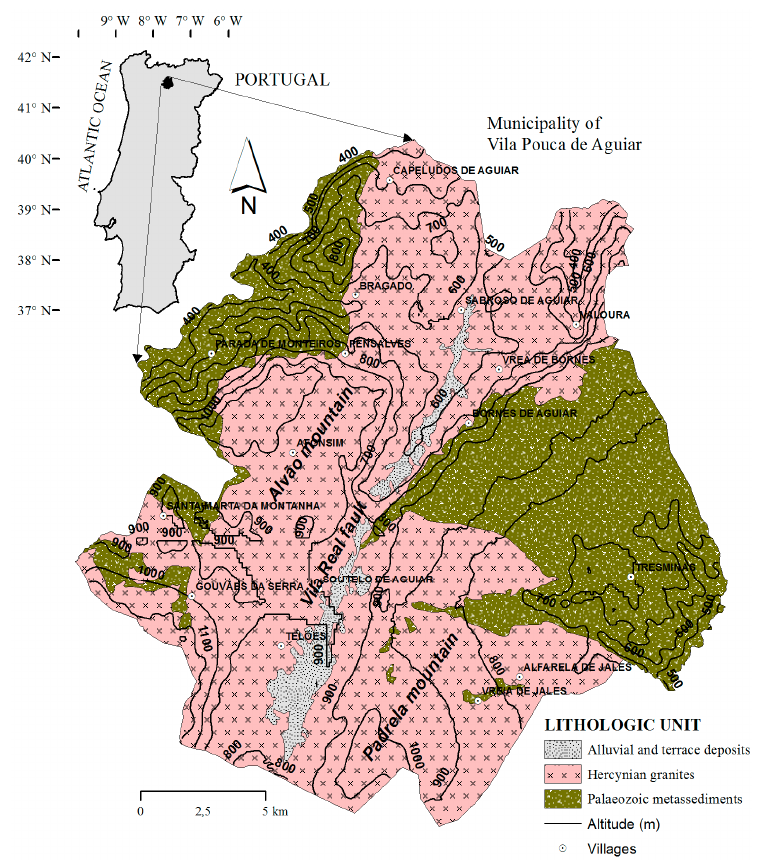
Figure 1. Location, geology and altitude contours in the Vila Pouca de Aguiar municipality.